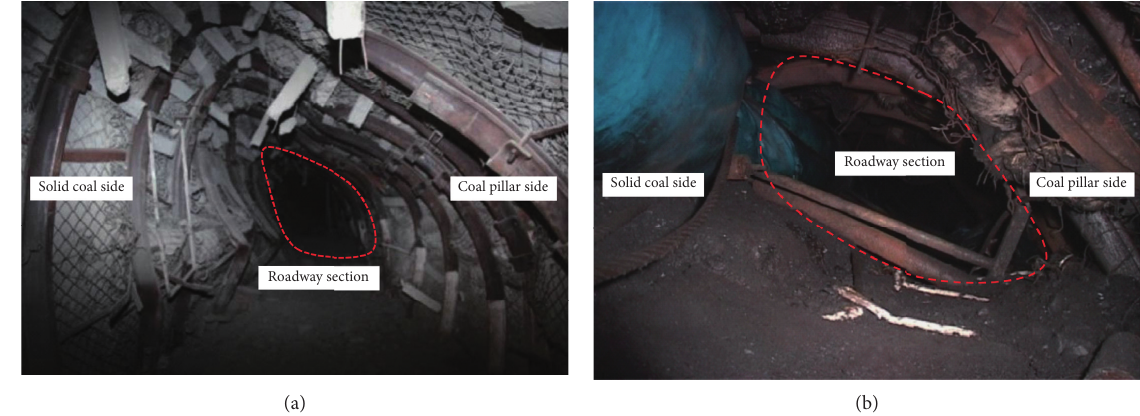
Figure 11: Photos of large deformation and rock burst in 1411 tail gate. (a) Roadway large deformation. (b) Roadway rock burst.